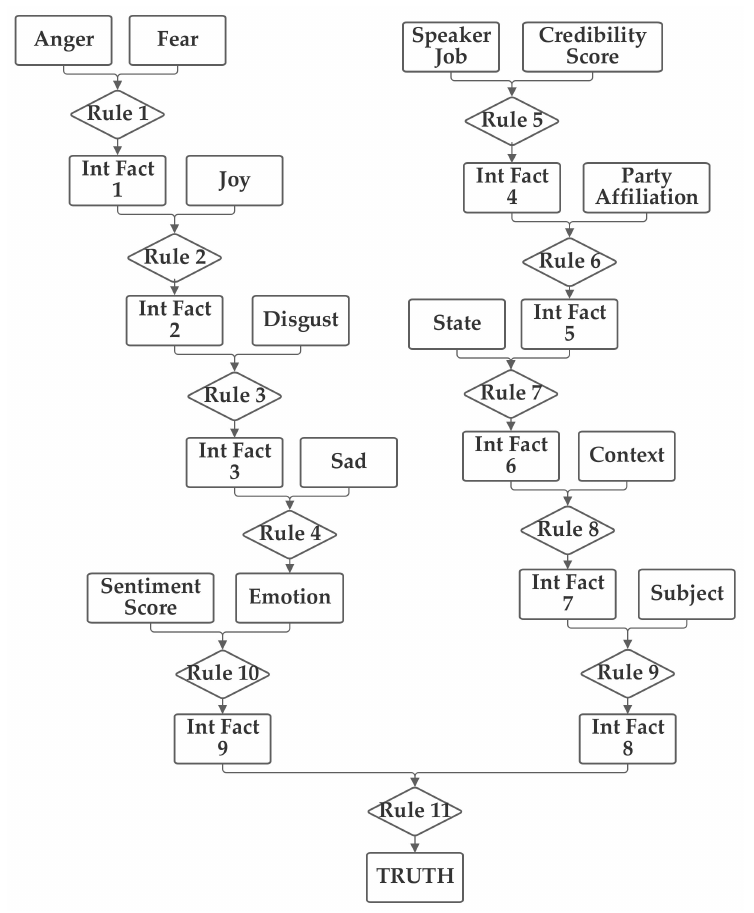
Figure 10. Depiction of Network